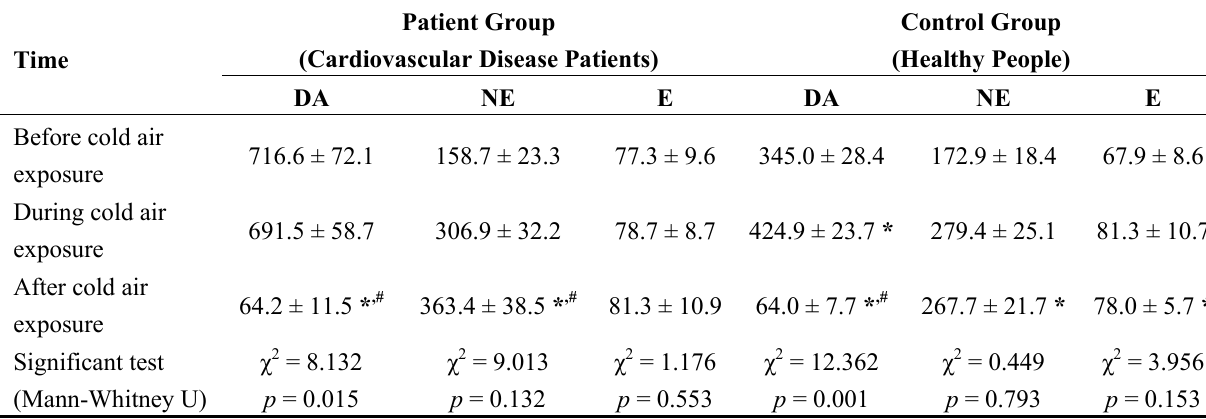
Table 3. Average catecholamine levels in the patient and control groups during a cold air event (mean ± standard deviation,